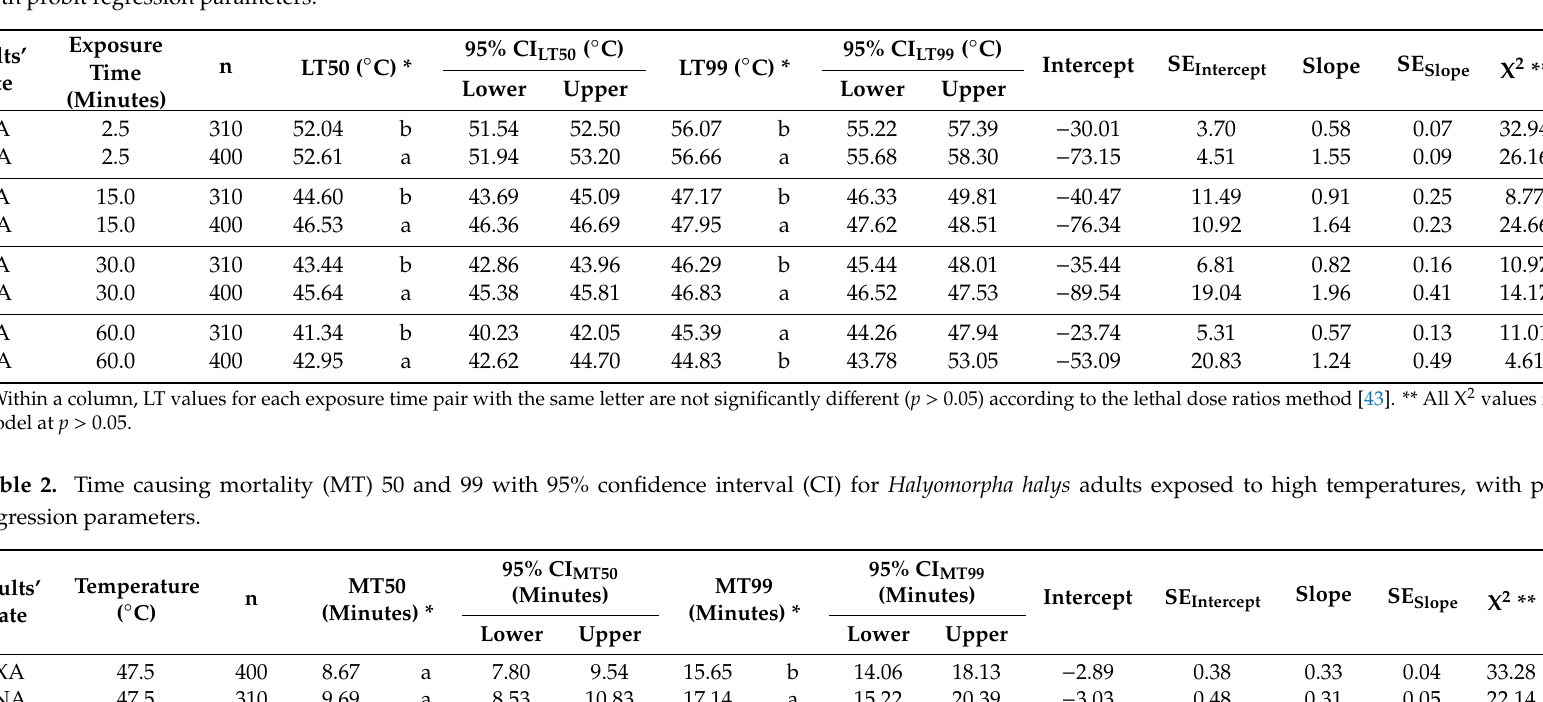
Table 1. Lethal high temperatures (LT) 50 and 99 with 95% confidence interval (CI) for Halyomorpha halys adults of the two investigated states (i.e., ENA and EXA), with probit regression parameters.